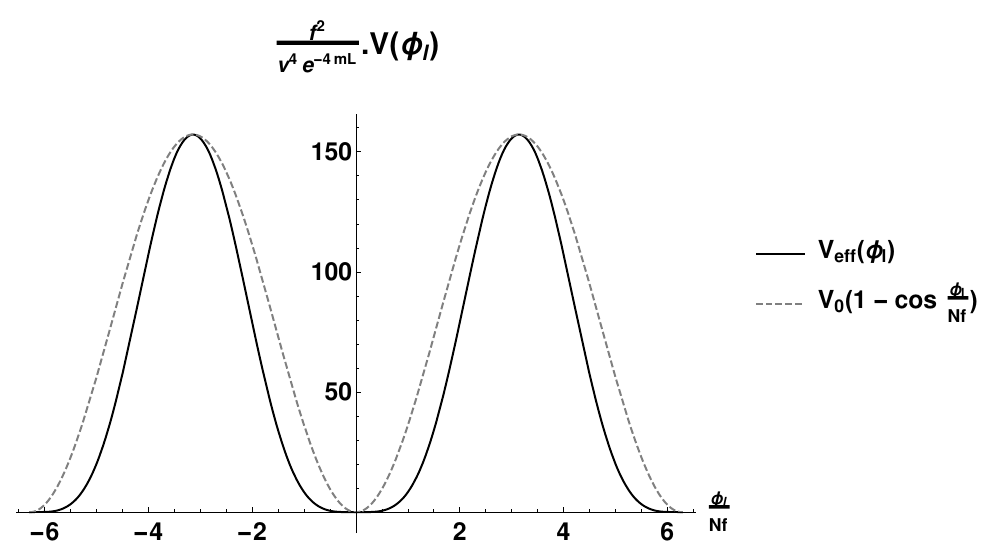
Figure 3 . The dark line refers to the e(cid:11)ective in(cid:13)ationary potential V e(cid:11) ( (cid:30) l ) after numerically integrating out the heavy (cid:12)elds (cid:17) h ; (cid:30) h ; (cid:17) l all along the in(cid:13)ationary trajectory. For comparison, a pure cosine potential with the magnitude matching to that of V e(cid:11) ( (cid:30) l ) is plotted as the dashed line. In(cid:13)ation can start close to the hilltop of V e(cid:11) ( (cid:30) l ), with V inf (cid:24) v 4 e (cid:0) 4 mL f 2